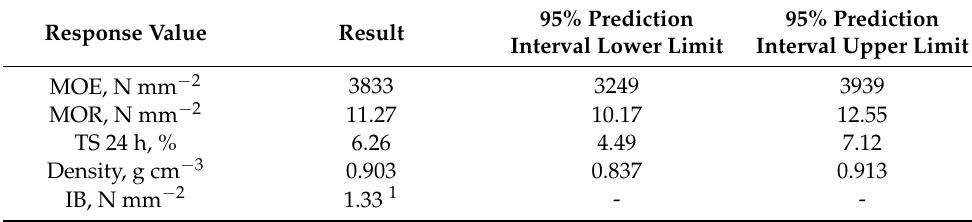
Table 11. Mechanical properties of particle boards obtained under optimal